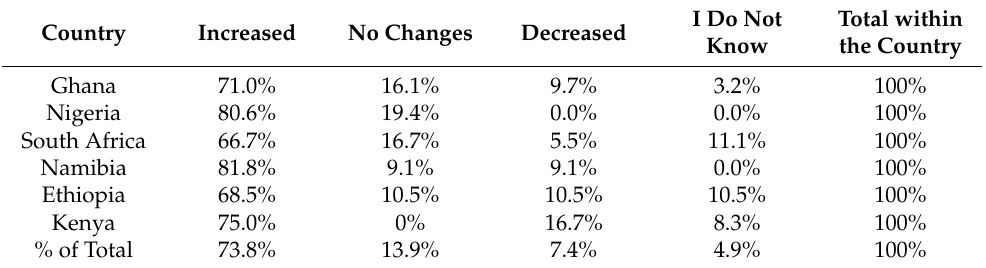
Table 5. Sampled countries’ diseases trend from the past until now as perceived by